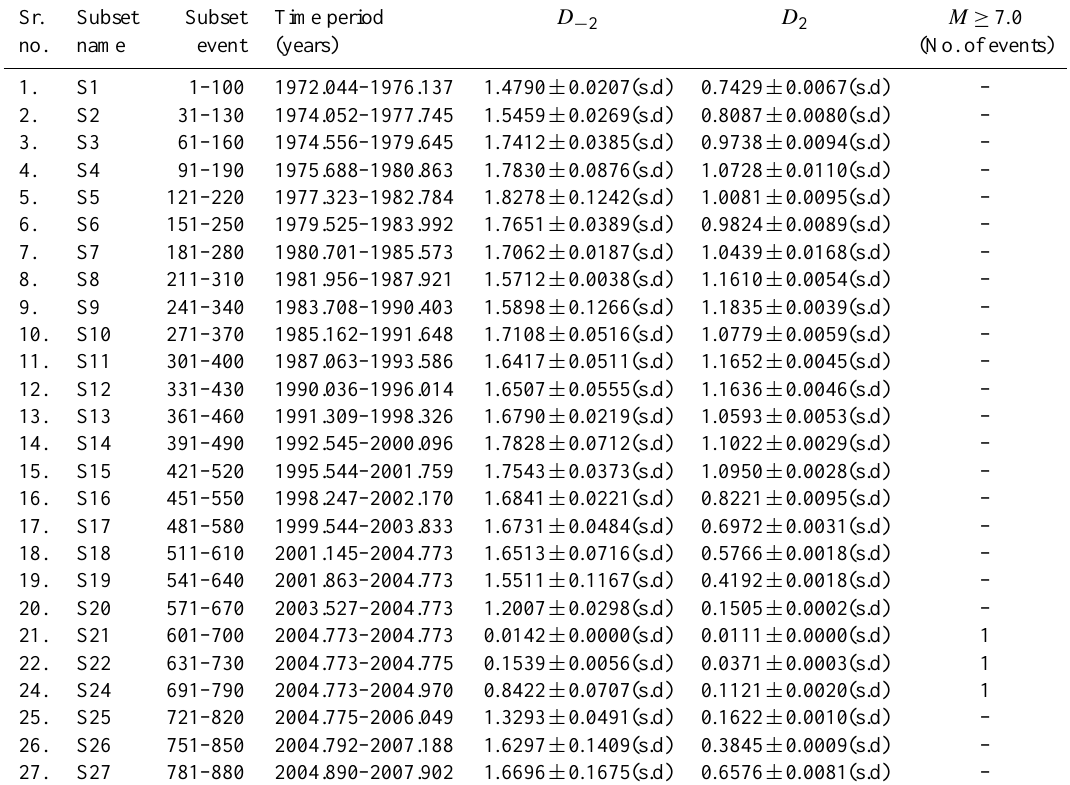
Table 1. Showing the subsets description along with time periods and fractal dimension.